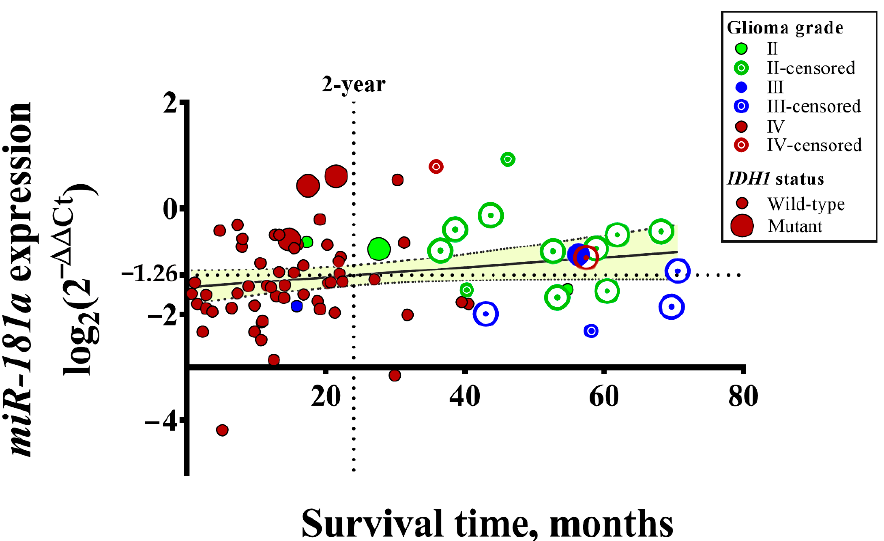
Figure 1. Distribution of patients with the diagnosis of different malignancy grade astrocytoma tumors, according to patient survival time and expression of miR-181a . The average of miR-181a mRNA expression is − 1.26 (dotted line in the y -axis). Pearson correlation r = 0.206, p = 0.071, yellow area represents 95% confidence interval. Table 1. The relationships between gene expression of miR-181a and patient clinical characteristics. Variables Total